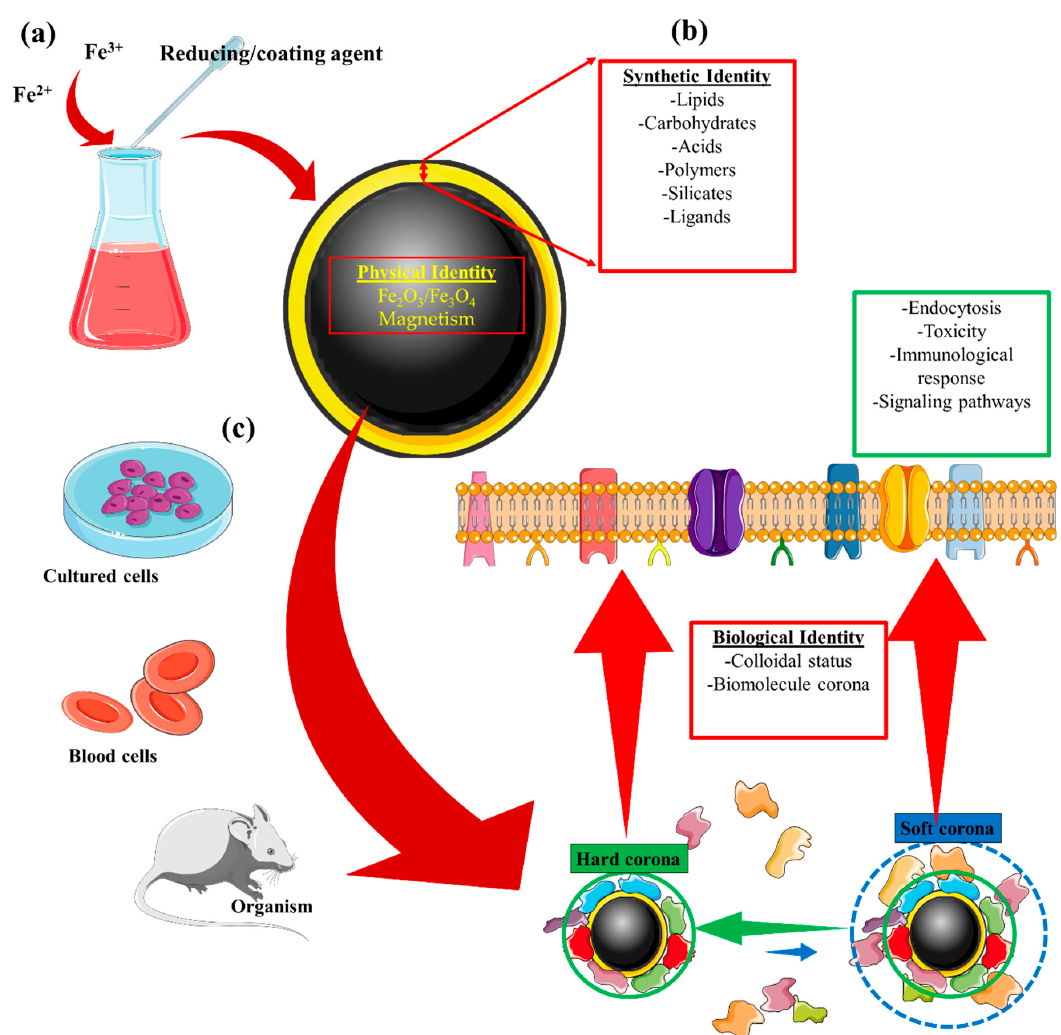
Figure 1. Iron oxide nanoparticle (IONP) identities and their relationships. ( a ) The core synthesis of IONPs provides the nanomaterial with its physical identity. For instance, the production of a small IONP (<20 nm) results in superparamagnetic nanoparticles. ( b ) The synthetic identity provides an added layer aimed at improving the functionality of the synthesized nanomaterial. Multiple coatings can be engineered on the IONP core to facilitate its application. ( c ) When the synthesized IONP interacts with physiological fluids, its properties can be altered. Referred to as the biological identity of the nanomaterial, this concept accounts for changes made to the colloidal status of the IONP after the formation of a biomolecule corona surrounding the IONP. This, in turn, can a ff ect IONP endocytosis, cells with which it comes into